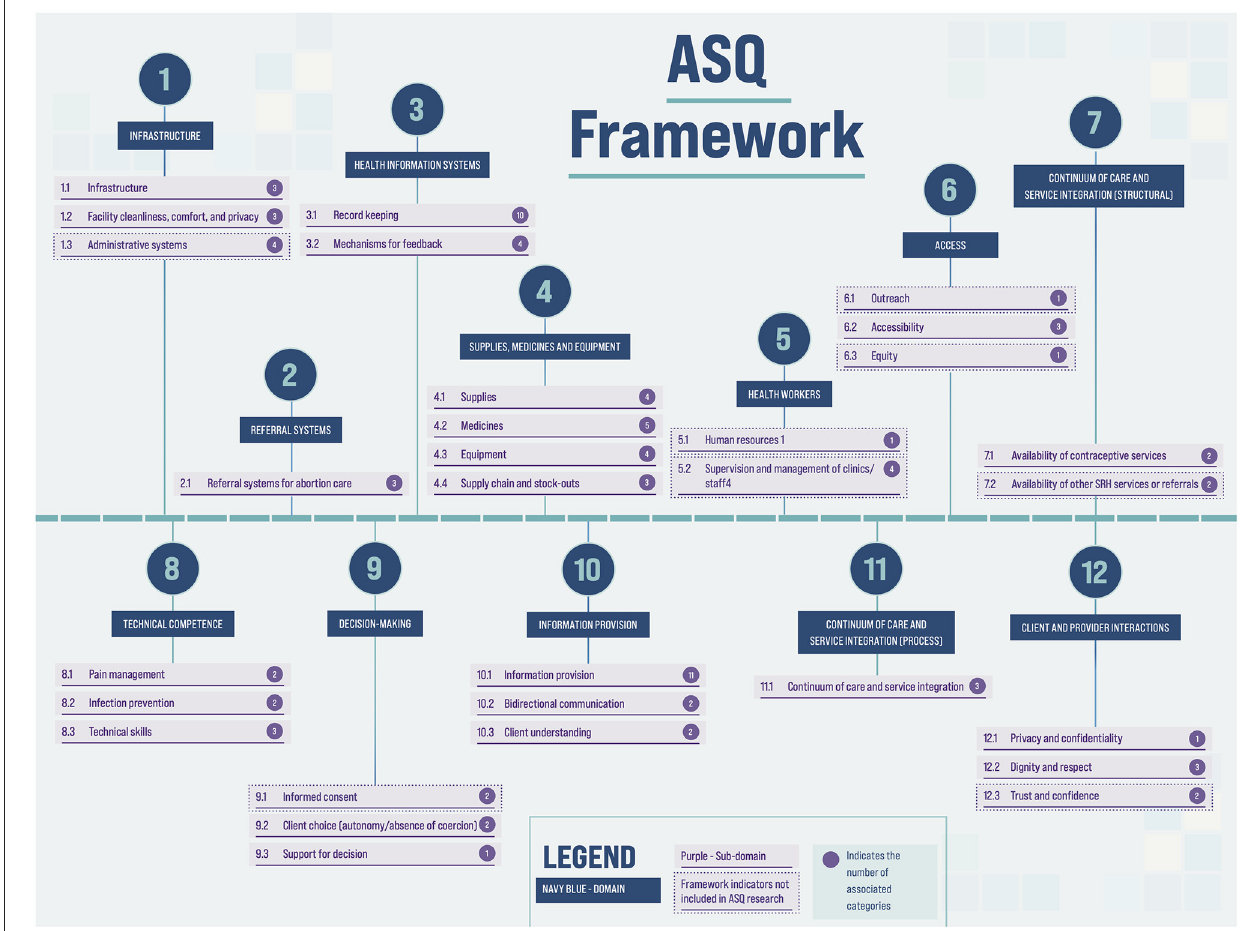
FIGURE 1 | ASQ indicator